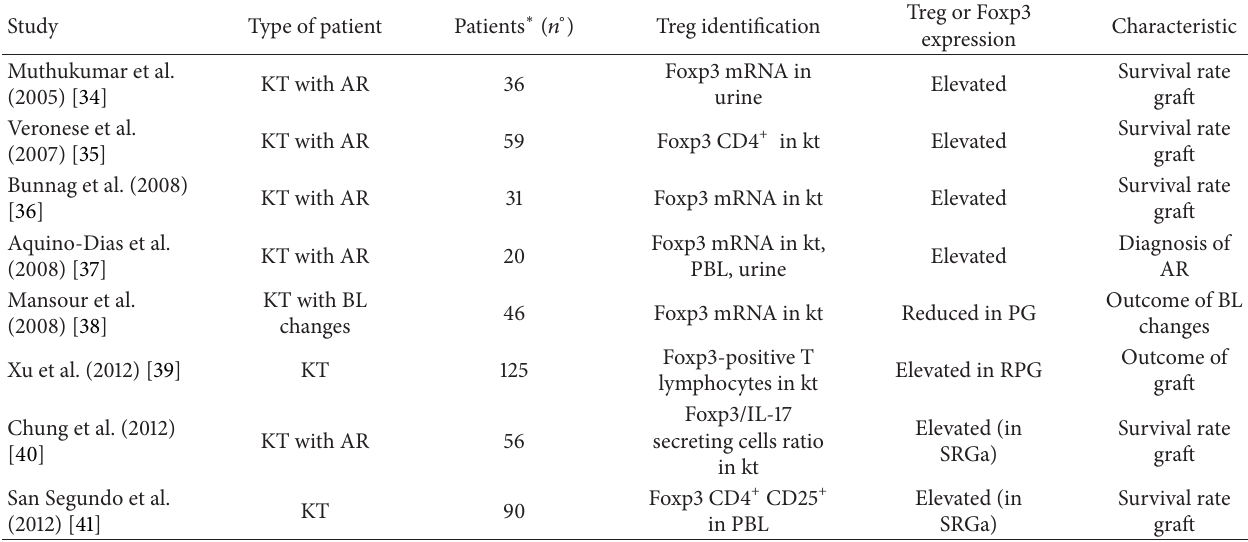
Table 1: Characteristics of the described studies.